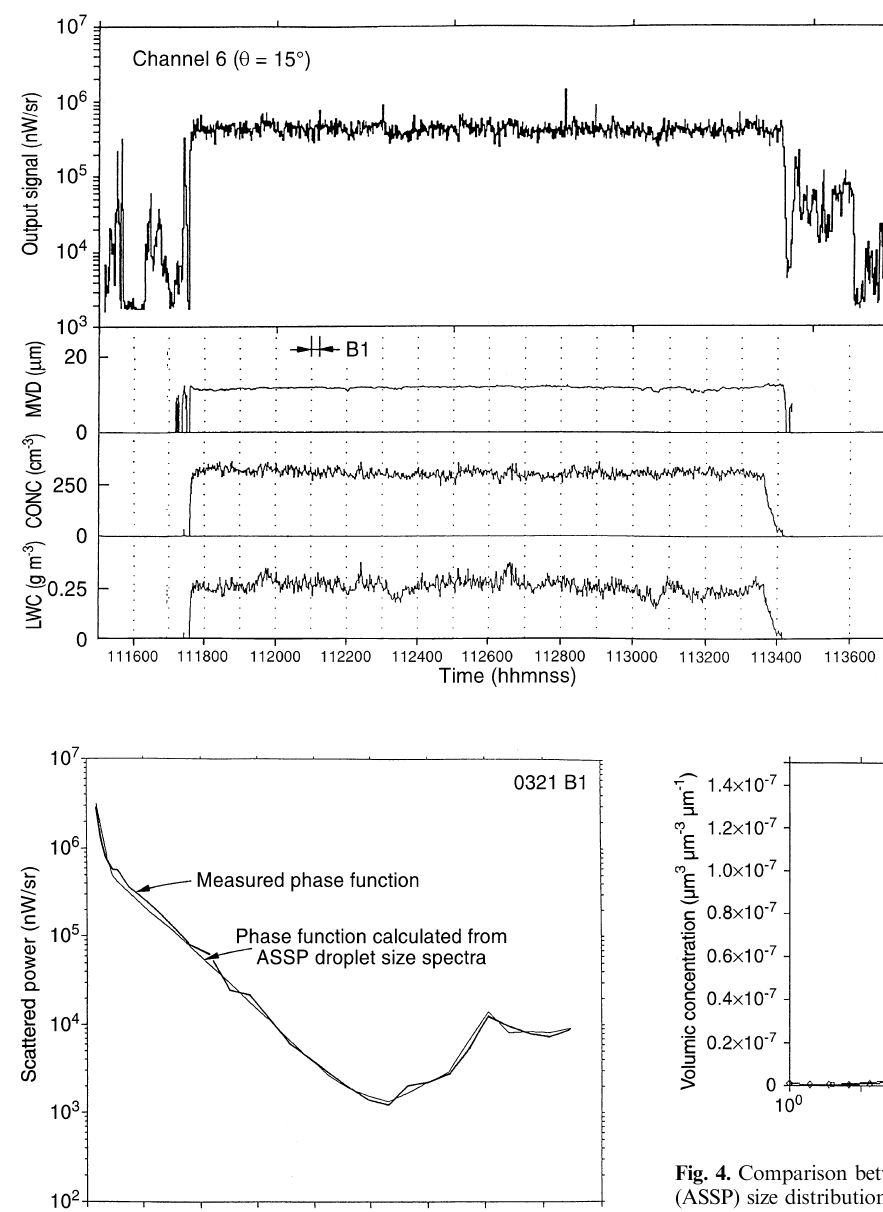
Table 1. Comparison between direct and retrieved microphysical parameters (CONC: cloud droplet concentration, LWC: